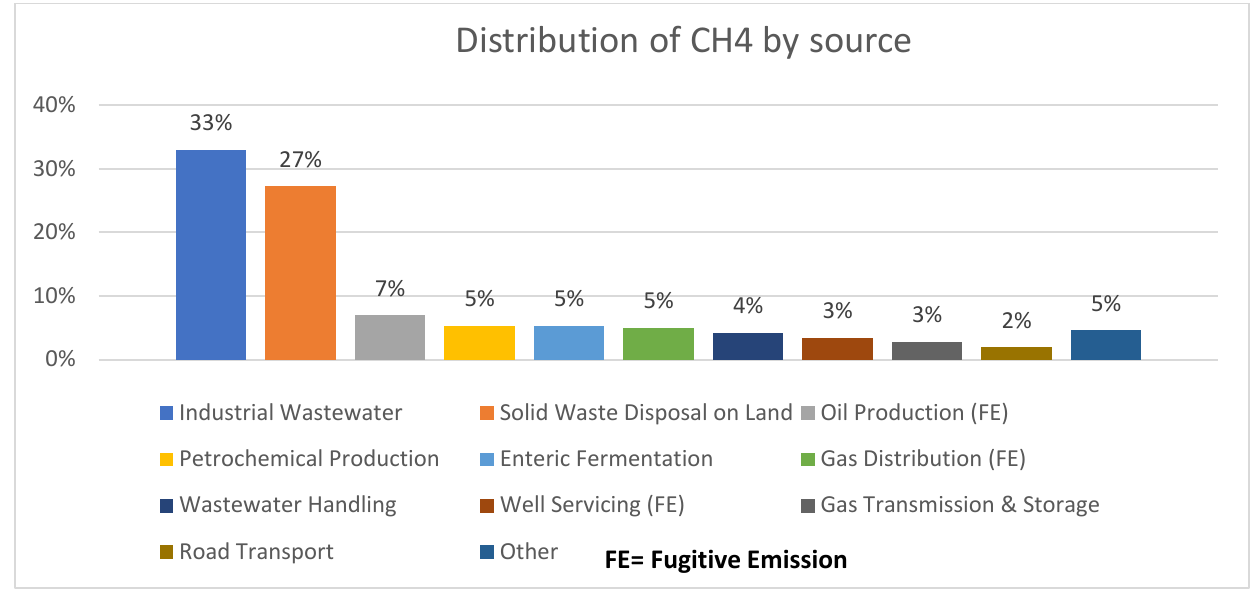
Figure 4. Saudi Arabia’s distribution of CH emissions by source in 2016 [31].